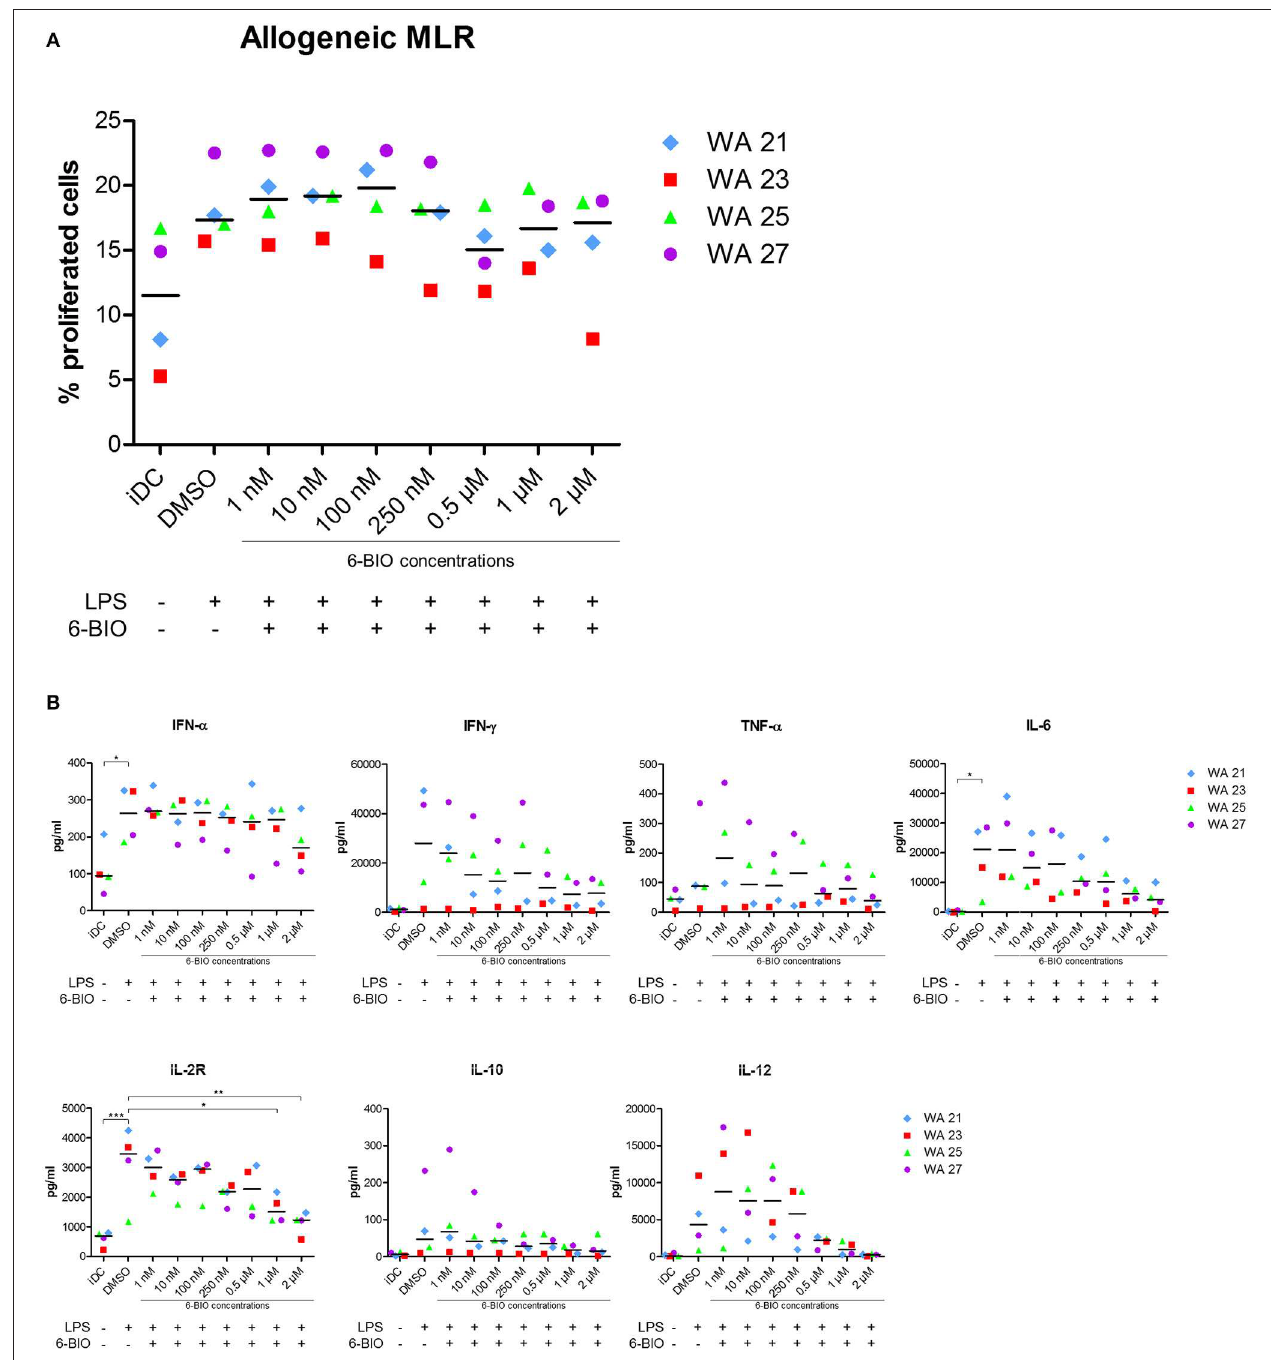
FIGURE 6 | Mixed leukocyte reaction (MLR) between moDCs and allogeneic peripheral blood mononuclear cells (PBMCs) obtained from healthy donors. moDCs were treated with indicated concentrations of 6-BIO or DMSO for 24h with 30ng/ml of LPS treatment for 23h, or left untreated as iDC. Allogeneic PBMCs were pre-labeled with CFSE and co-cultured with treated moDCs for 5 days. (A) Percentage proliferated cells was measured by reduction in CFSE intensity. (B) The amount of secreted cytokines was analyzed using 25-Plex Panel, and the concentrations are given in pg/ml. Each symbol represents a different donor, and lines represent the median. * p ≤ 0.05, ** p ≤ 0.01, *** p ≤ 0.001, using one-way ANOVA with Dunnett’s multiple comparisons test and 95% confidence interval.